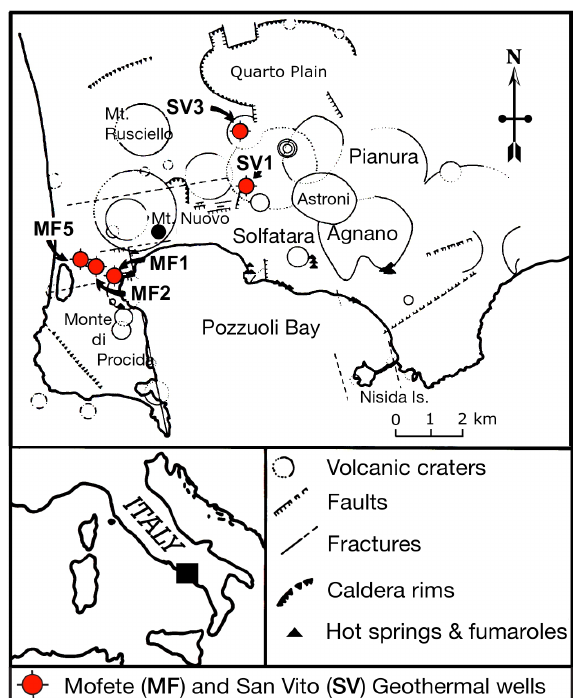
Figure 1. Schematic location map adapted from De Vivo et al. (1989) showing the Campi Flegrei caldera complex, various ge- ologic features, and the positions of the five Mofete and San Vito geothermal wells (MF1, MF2, MF5, SV1, and